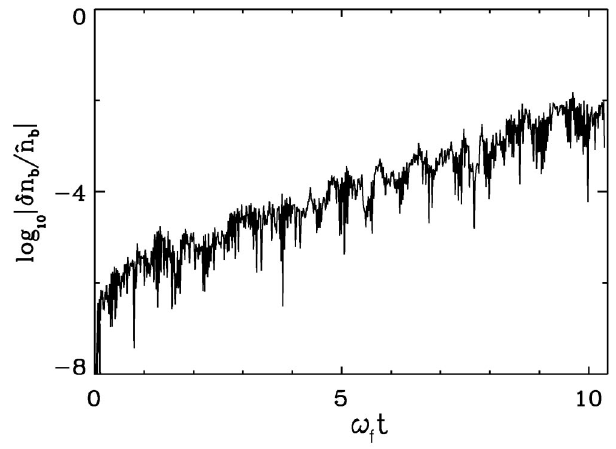
= ^ n at a fixed b b